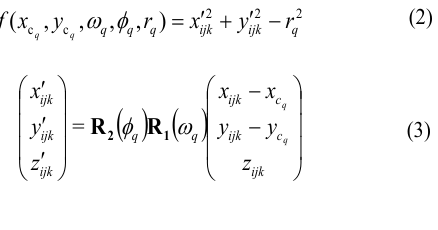
Figure 7. The over-segmented circle (green) by the GHT from the point cloud of a wall corner (red) After the circle recognition, the radius histogram check method (Ioannou et al., 1999) is applied (Figure 6d) for each circle to check if they are over-segmented by the GHT. Sometimes corner regions between two high-density walls as shown in Figure 7 might be treated as a circle by the GHT. The radius histogram check basically counts the distance between each point to the centre. If it is a circular feature there will be a sharp peak at the radius of the circle. In this work, the peak threshold was set to be 90% within a radius window (r 0 ± 3 cm). Finally, the extracted circles with an added buffer (the dashed green lines in Figure 6e) in the middle layer are projected to the other layers to form a 3D cylinder window segmenting the cylinder point cloud. This is followed by least-squares fitting to estimate the cylinder parameters and also to remove blunders. The vertical cylinder model (f) for cylinder q is given